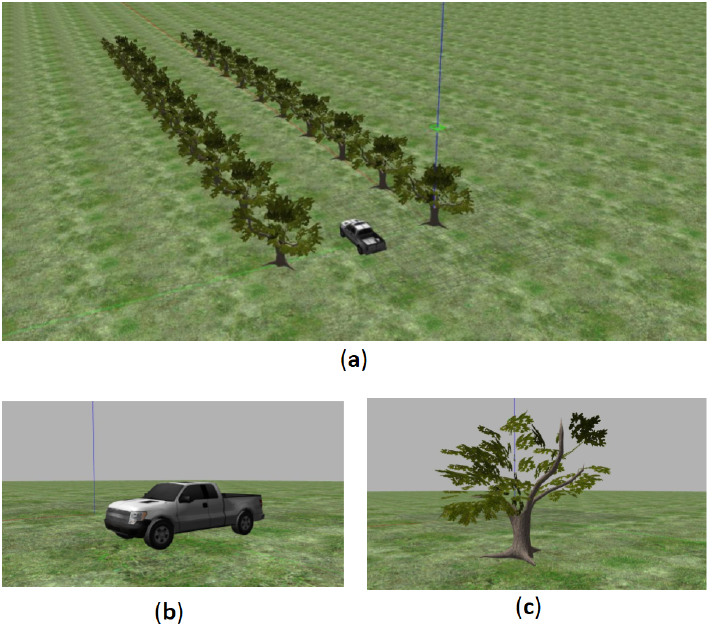
Figure 5. Environment built in the Gazebo software. ( a ) Simplified world used for training DQN. ( b ) Pickup model. ( c ) Olive-tree model.